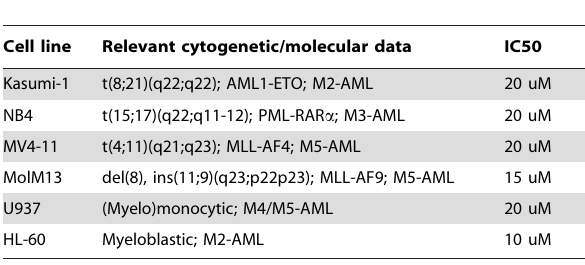
Table 1. IC50 values and relevant cytogenetic/molecular data for AML cell